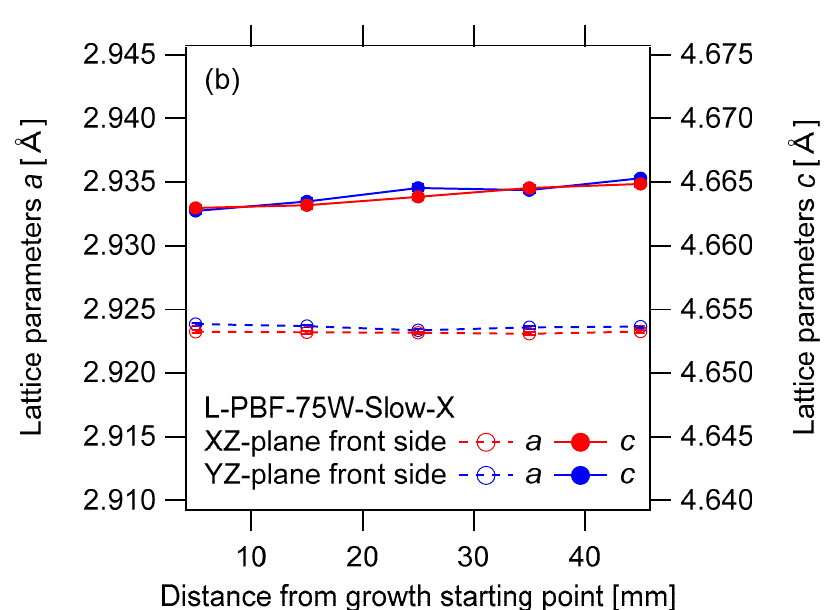
Figure 9. α or α ’ phase lattice parameters measured at different locations on ( a ) L-PBF-360W-Fast-X and ( b ) L-PBF-75W-Slow-X. The data points on the front sides, colored red and blue in Figure 1, are shown. The c -axis became longer as the parts grew in the Z-direction. This trend was more significant in L-PBF-360W-Fast-X than in PBF-75W-Slow-X. In L-PBF-360W-Fast-X, the c -axis on the XZ plane was longer than that on the YZ plane.